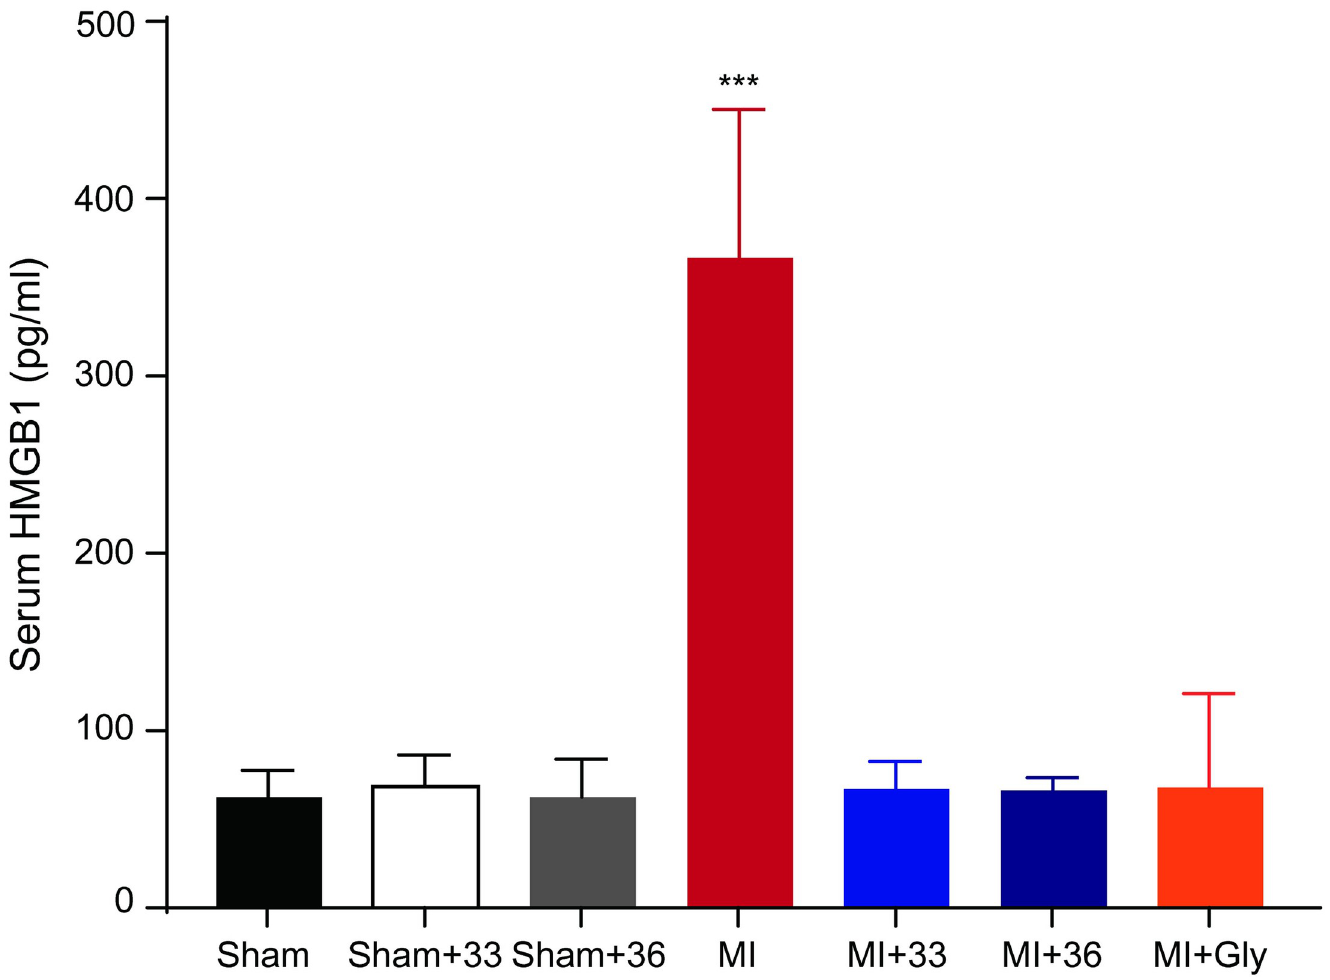
Fig 6. Quantification of levels of HMGB1 in plasma. Quantification of serum HMGB1 level by ELISA comparing myocardial I/R with normothermia, hypothermia (33˚C and 36˚C), and glycyrrhizin pre-treatment (number of animals: n = 5), ��� P < 0.001, Statistical analyses were performed by one-way analysis of variance (ANOVA) followed by Bonferroni post hoc tests for multiple comparisons between